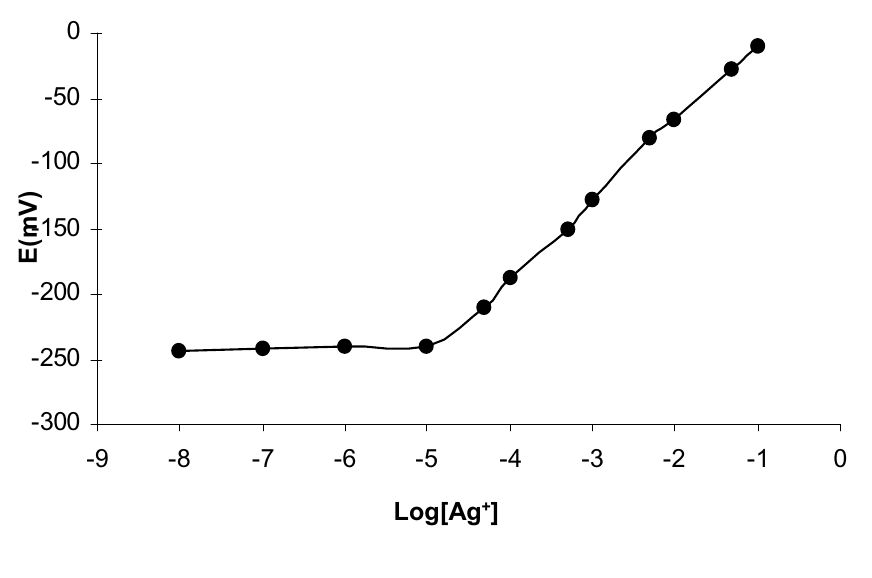
Figure 1. Potential responses of silver ion sensors based on